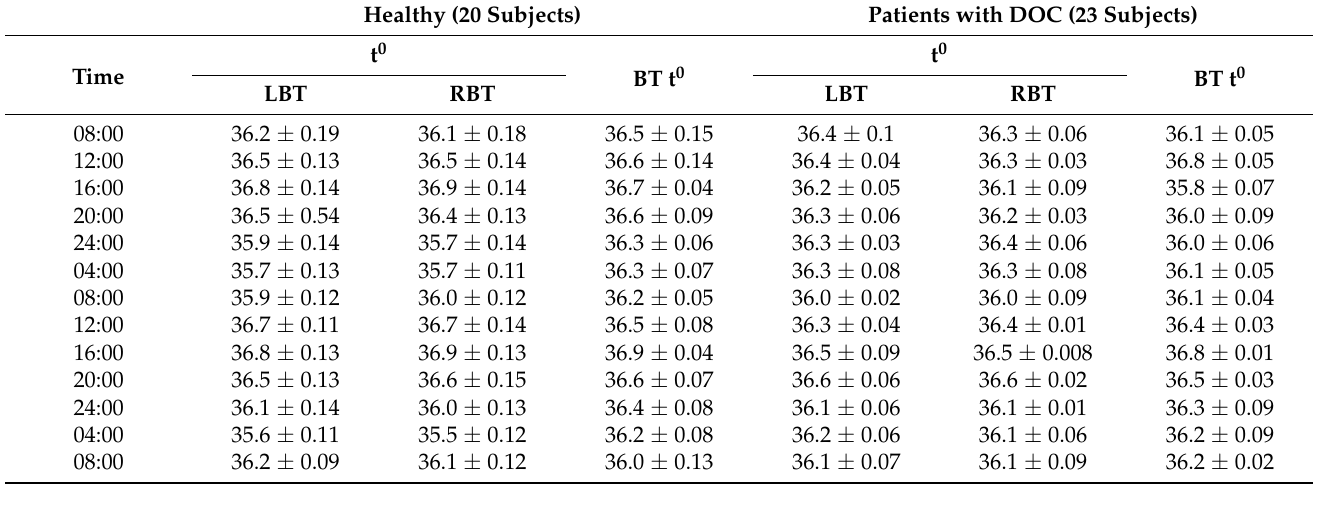
Table 2. Mean temperature values of the cerebral cortex (LBT — left hemisphere and RBT — right hemisphere) and body temperature (BT) during 2 days in healthy people and patients with DOC.